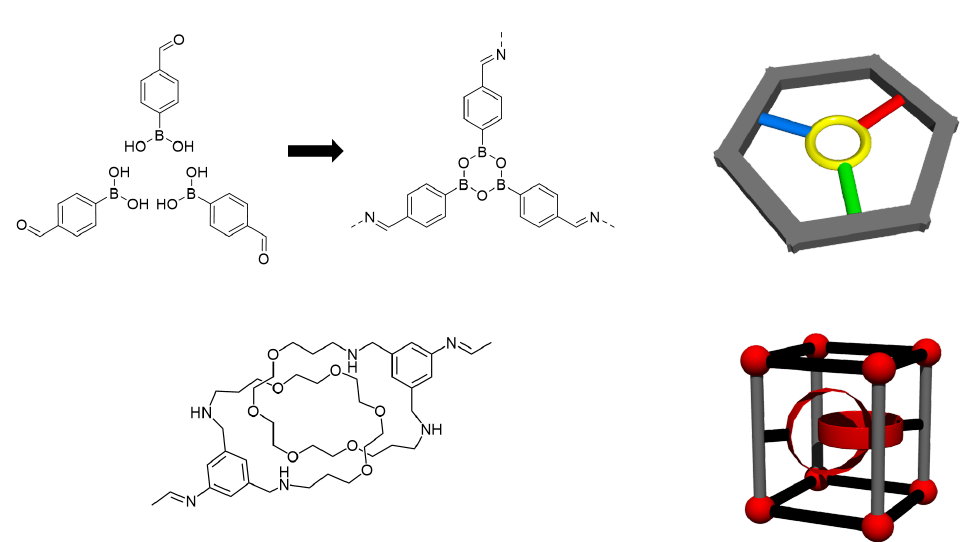
Figure 9. Catenane and “ship in a bottle” examples.